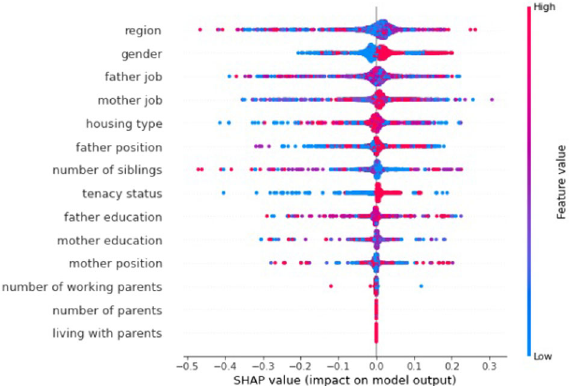
Fig. 1 Decision tree classi fi cation SHAP summary plot. Note: (1) The order from the top vertically indicates the importance of the variable. (2) Red color indicates a high value and blue color indicates a low value of the variable. (3) The horizontal axis denotes the impact of the value of the variable on the output. (4) The density achieved by the dots indicates their intensity.